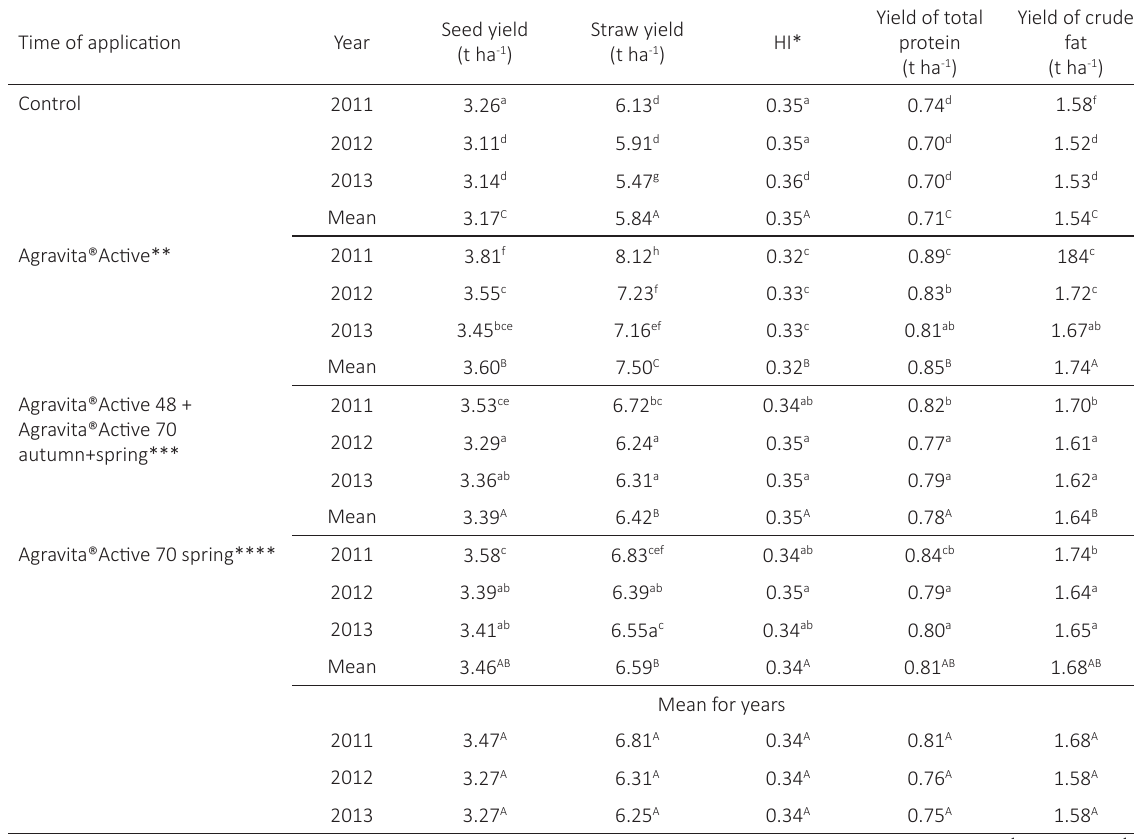
Straw yield Seed yield (t ha -1 ) (t ha -1 )